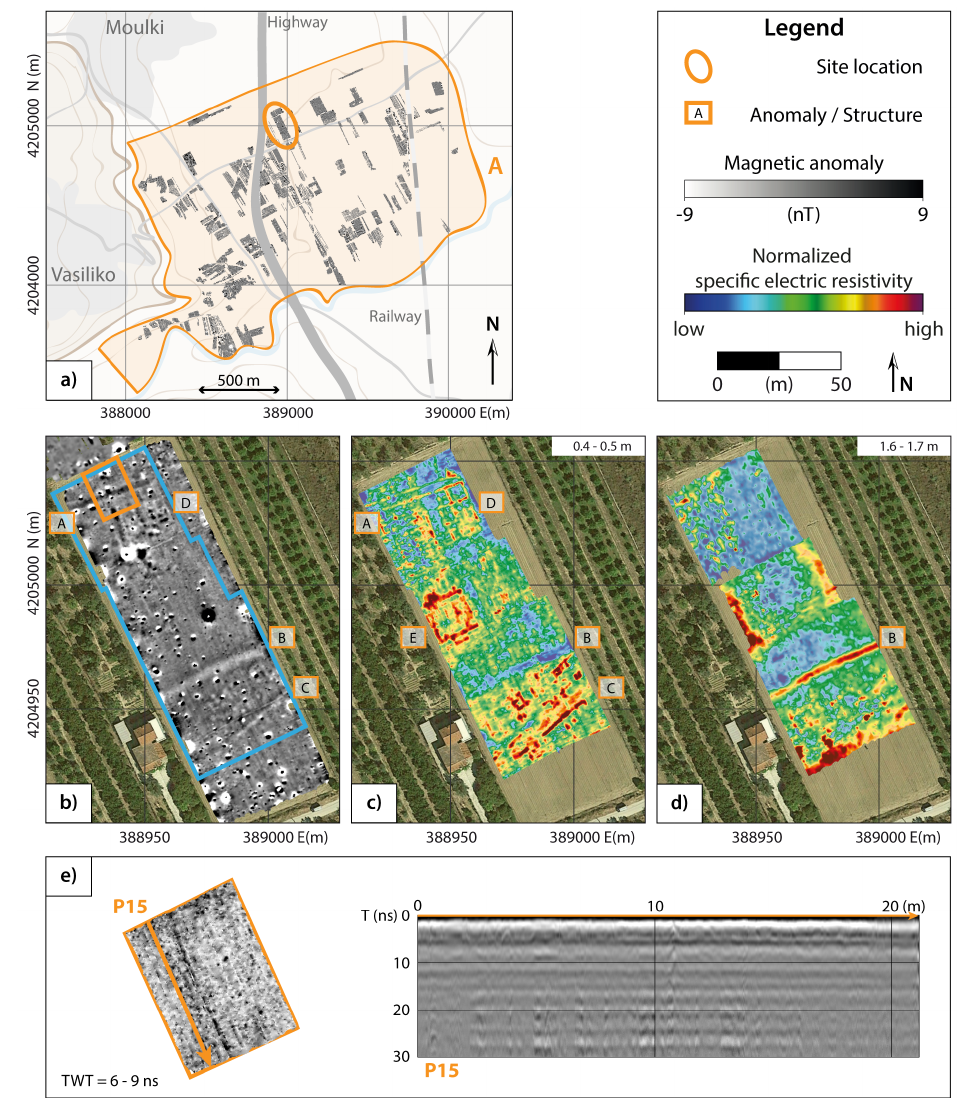
Figure 9. Case 5: Sikyon–Zogeri. ( a ) Sketch of survey area A (cf. Figure 1c) with magnetic map and the marked site location. ( b ) Results of the magnetic mapping. ( c ) 0.4–0.5 m depthslices of electrical resistivity tomography (ERT) survey. The amplitudes were normalized to join the individual partial areas together (cf. Figure 3). ( d ) 1.6–1.7 m depthslice of the ERT survey. ( e ) Ground-penetrating radar test; exemplary timeslice of 6–9 ns (left) and radargram of P15 (right). Source of satellite images ( b – d